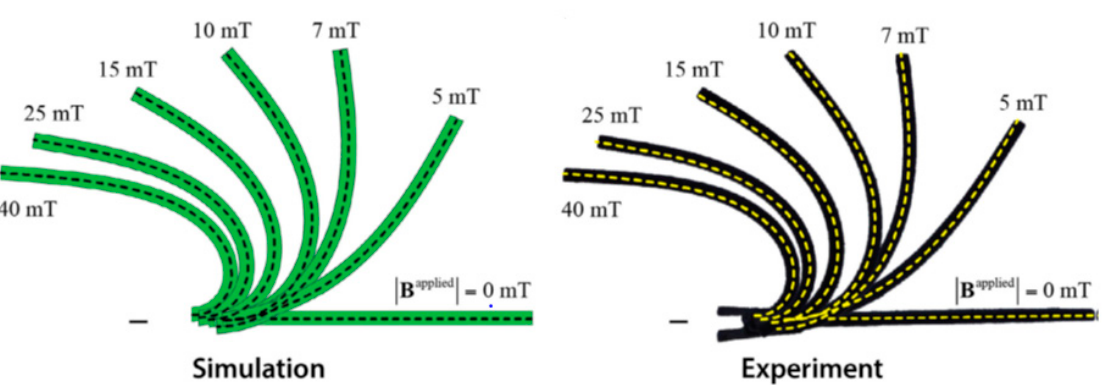
Figure 14. Validation of the developed finite element analysis model [60] .